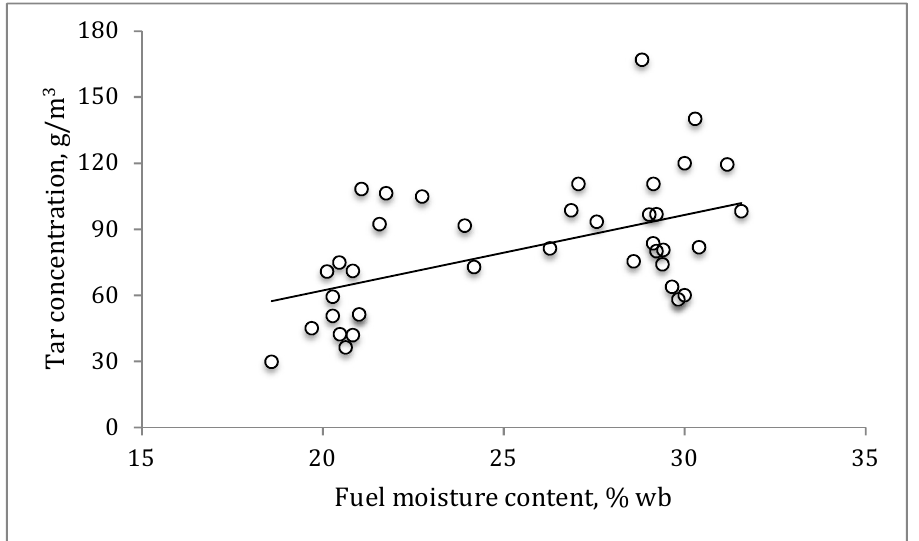
Figure 7. Tar concentration vs. fuel moisture content. Tests done at the UBC gasifier.